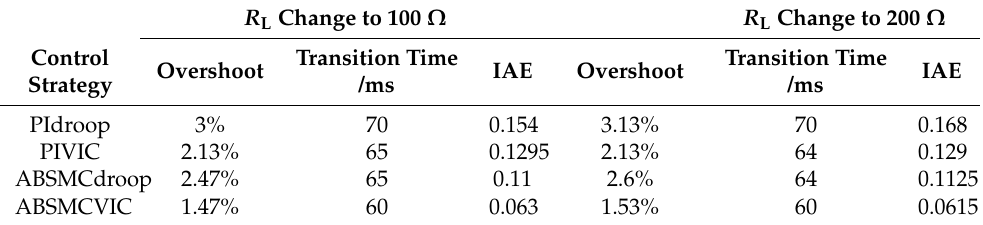
Table 5. The performance parameters of four different control methods. R L Change to 100